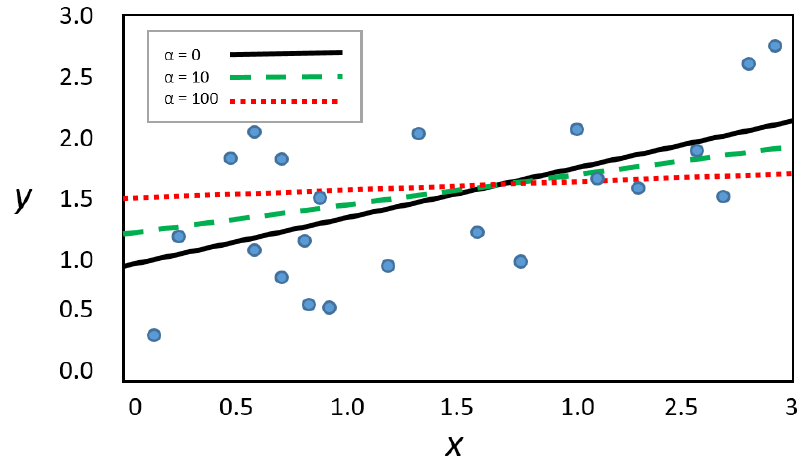
Figure 2. Ridge regression with different values of α